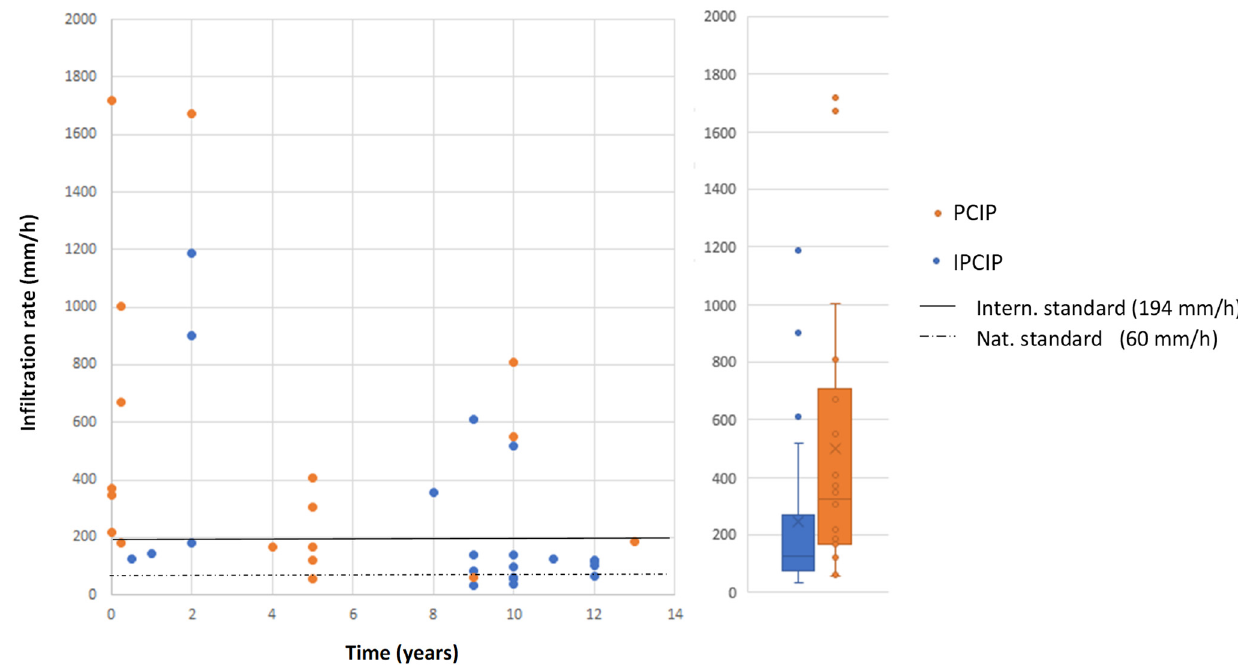
Figure 3. Functioning of infiltrating pavements in practice. Figure 1a shows the infiltration rate of PCIP (orange) and IPCIP (blue) systems under uncleaned and unsaturated conditions versus time. Solid and hatched lines indicate the international and national standards. Figure 1b shows the spread (mean (visualized by the X) +- 1 standard deviation in the box and whiskers) in infiltration read per PCIP (orange) and IPCIP (blue) system. Individuals observations are visualized by the dots.